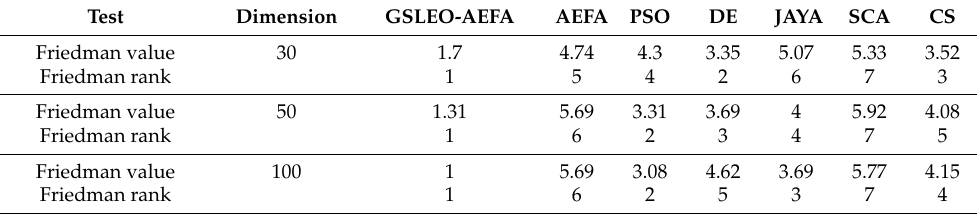
Table 7. Friedman test for dimension 30, 50, and 100 dimensions for 20